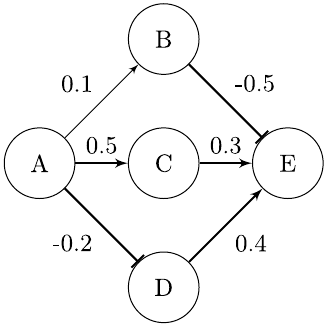
Figure 1. Schematic of converting a dense network into a sparse graph by choosing the five strongest edges. Weak edges are interpreted as a not existing connection (A (cid:31) B). Positive weights are activating (A → C, C → E, D → E) and negative weights are inhibiting (A ⊣ D, B ⊣ E)